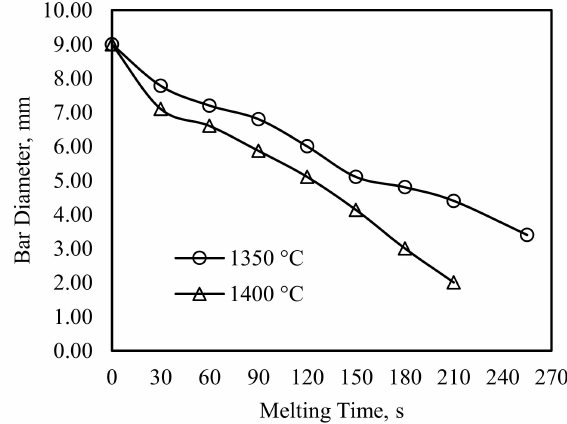
Figure 4. Diameter change of the scrap bar at di ff erent bath